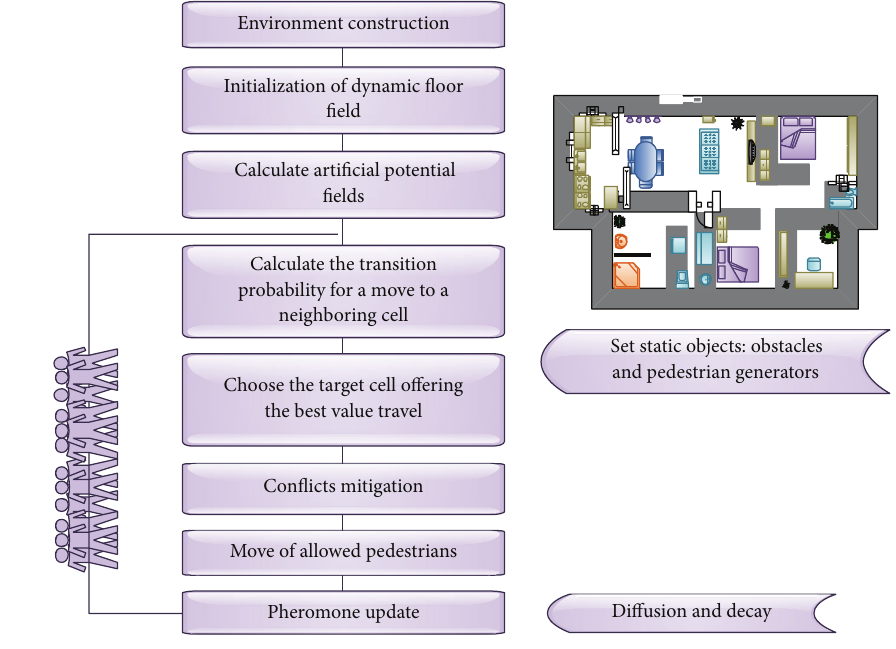
Figure 5: Simulation algorithm.